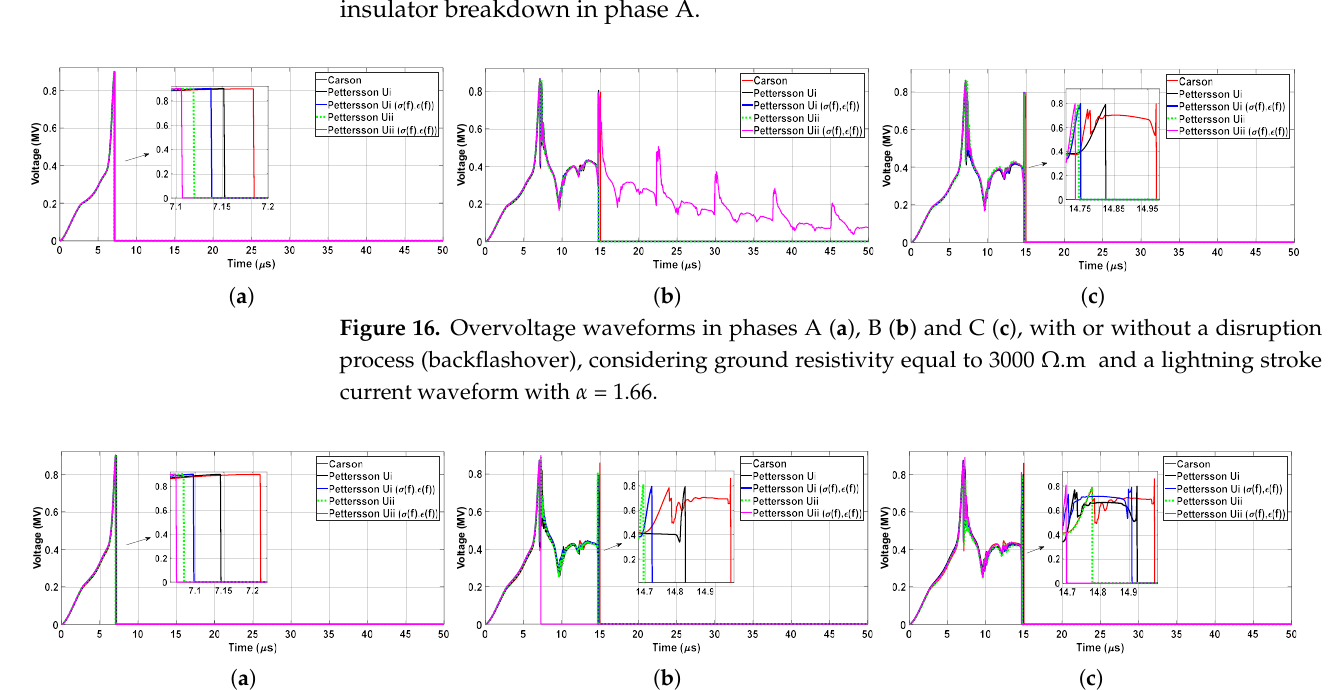
Table 5. Sensitivity of backflashover occurrence as a function of the transmission line model.